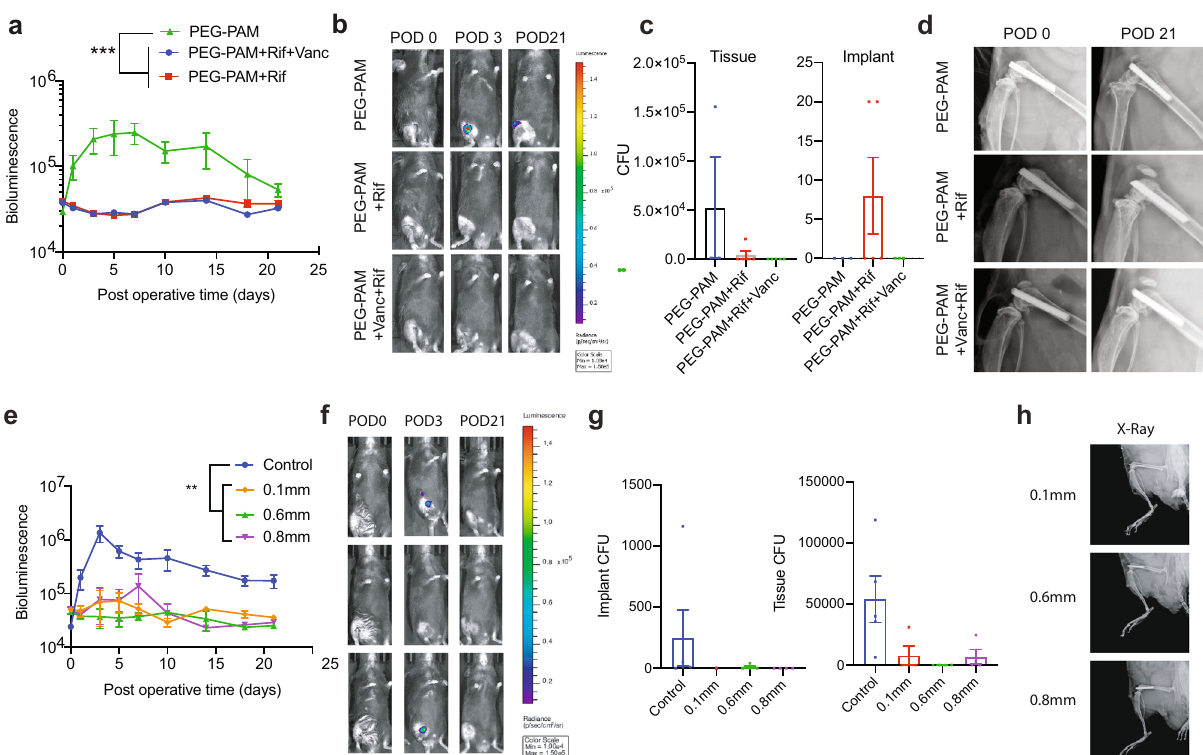
Fig. 6 In vivo evaluation of PEG-PAM coatings with combination of Rifampin and vancomycin. ( a ) Postoperative in vivo S. aureus bioluminescence signals (mean maximum fl ux [photons/sec/cm 2 /sr] (logarithmic scale) ( n = 6 for PEG-PAM only group, n = 6 for PEG-PAM + Vanc group, n = 6 for PEG- PAM + Vanc + Rif). b Representative in vivo S. aureus bioluminescence on a color scale overlaid on grayscale images of mice. c Representative radiographs from the PEG-PAM, PEG-PAM with rifampin, PEG-PAM with vancomycin, and rifampin groups of POD 0 and 21. d Quanti fi cation of colony-forming units (CFUs) cultured from surrounding tissue and implant. In vivo evaluation of PEG-PAM coatings on different sized stainless-steel pins with vancomycin were evaluated. e Postoperative in vivo S. aureus bioluminescence signals (mean maximum fl ux [photons/sec/cm 2 /sr] (logarithmic scale, n = 5 for control group, n = 5 for 0.6 mm group, n = 5 for 0.8 mm group, n = 5 for 0.1 mm group). f Representative in vivo S. aureus bioluminescence on a color scale overlaid on grayscale images of PEG-PAM with vancomycin and vanc groups of POD 0, 3, and 21. g Quanti fi cation of colony-forming units (CFUs) cultured from surrounding tissue and implant. ( n = 5 for the control group, n = 4 for the 0.6 mm group, n = 4 for the 0.8 mm group, n = 4 for the 0.1 mm group). h X-ray images of implants (0.1, 0,6, and 0.8 mm). Statistics in ( a , e ) are a two-way-repeated measure-ANOVA with multiple comparisons post-test. The signi fi cance between treatment groups was *** p = 0.007 for ( a ) and *** p = 0.0001 for ( e ). Statistics in ( c and g ) are not signi fi cant using an ordinary one- way ANOVA. Data is plotted showing the Mean and Standard Deviation for bar plots and Standard Error of the Mean for time longitudinal